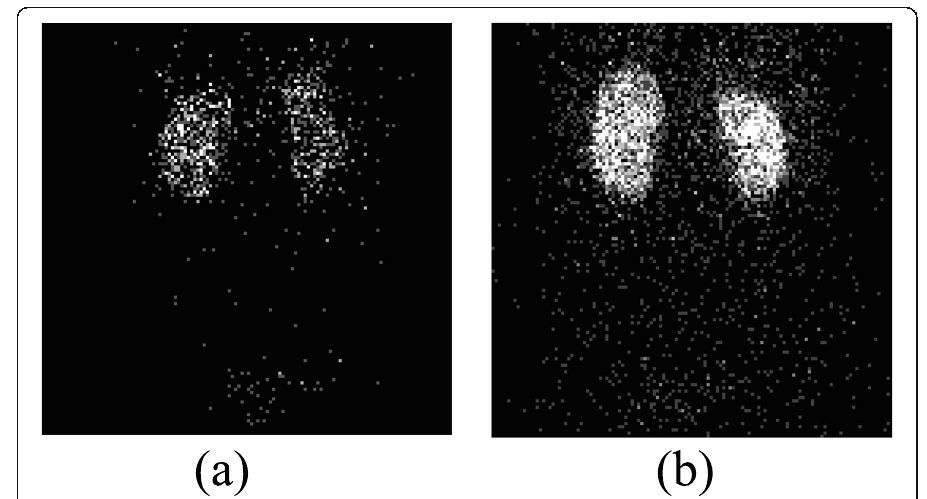
Fig. 2 99m Tc-DMSA raw projection SPECT images of a representative patient a anterior and b posterior